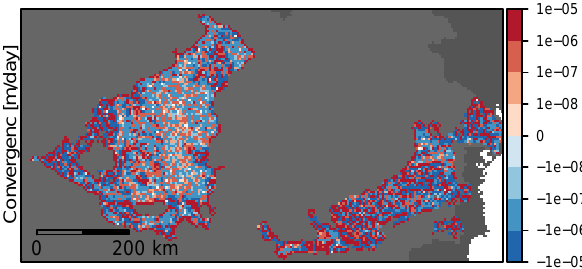
Fig. 8. Travel time of groundwater, in yrkm − 1 . Fig. 9. Magnitude of groundwater convergence ( c gw ), in md